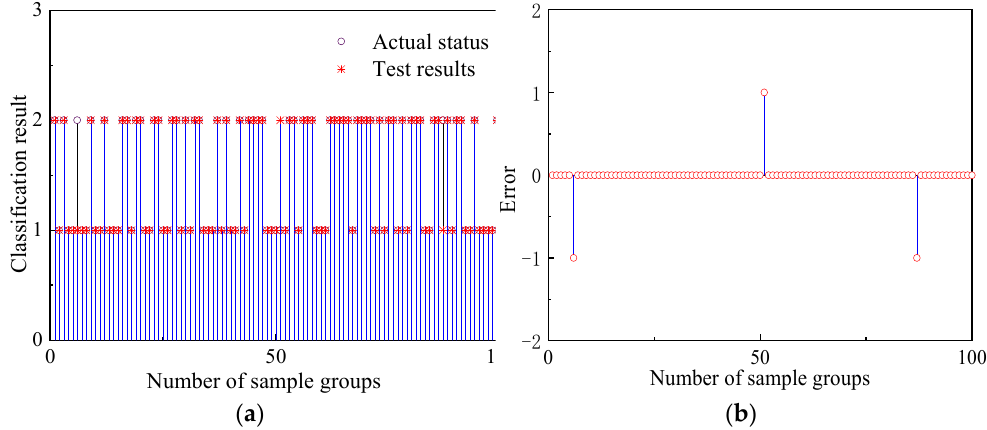
Figure 8. IPNN test effect diagram: ( a ) IPNN test data classification results; ( b ) IPNN test data detection error.